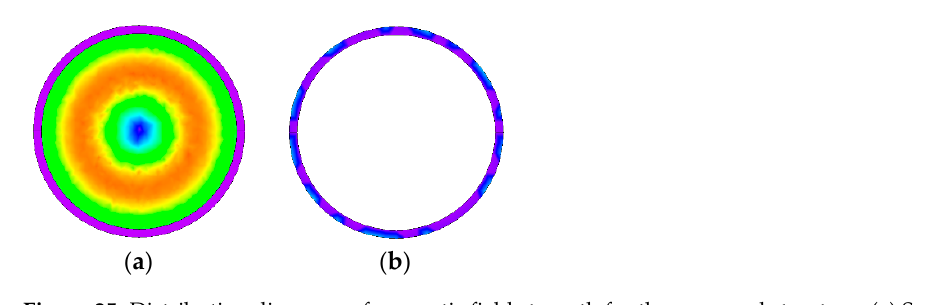
Figure 25. Distribution diagrams of magnetic field strength for the proposed structure. ( a ) Secondary shield. ( b ) Extended part.